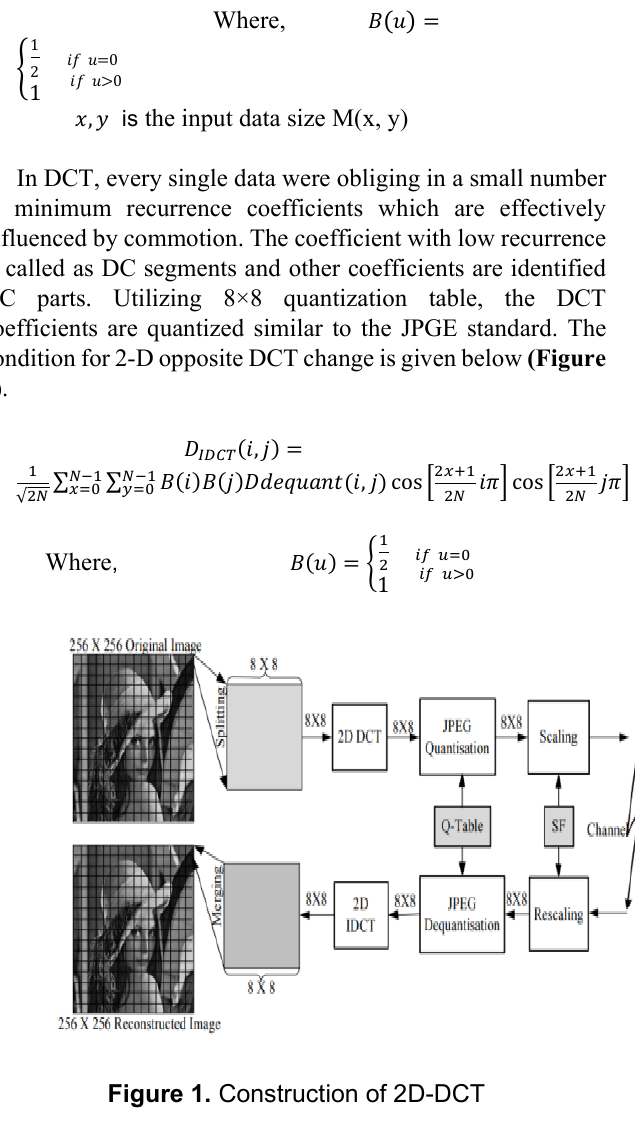
Figure 1. Construction of